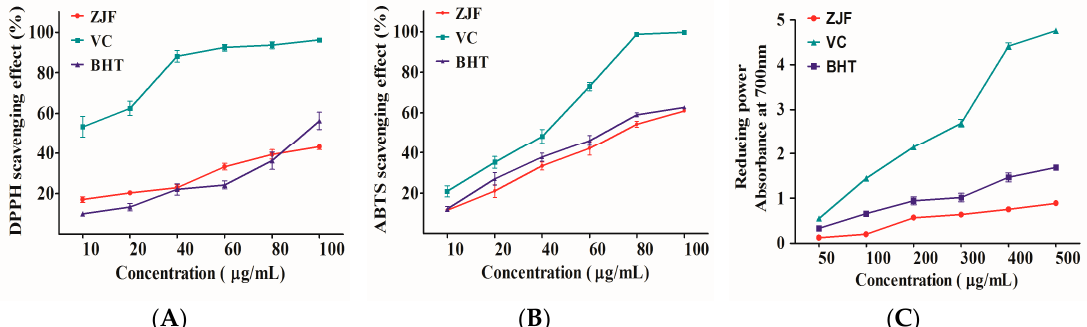
Figure 2. Antioxidant activity of ZJF: ( A ) 1,1-diphenyl-2-picrylhydrazyl (DPPH) radical scavenging assay; ( B ) 2,2 ′ -azino-bis(3-ethylbenzothiazoline-6-sulfonic acid) (ABTS) radical scavenging assay and ( C ) Ferric Reducing Power assay (FRAP). Data are shown as mean ± Standard Error of Mean (SEM) ( n = 3).